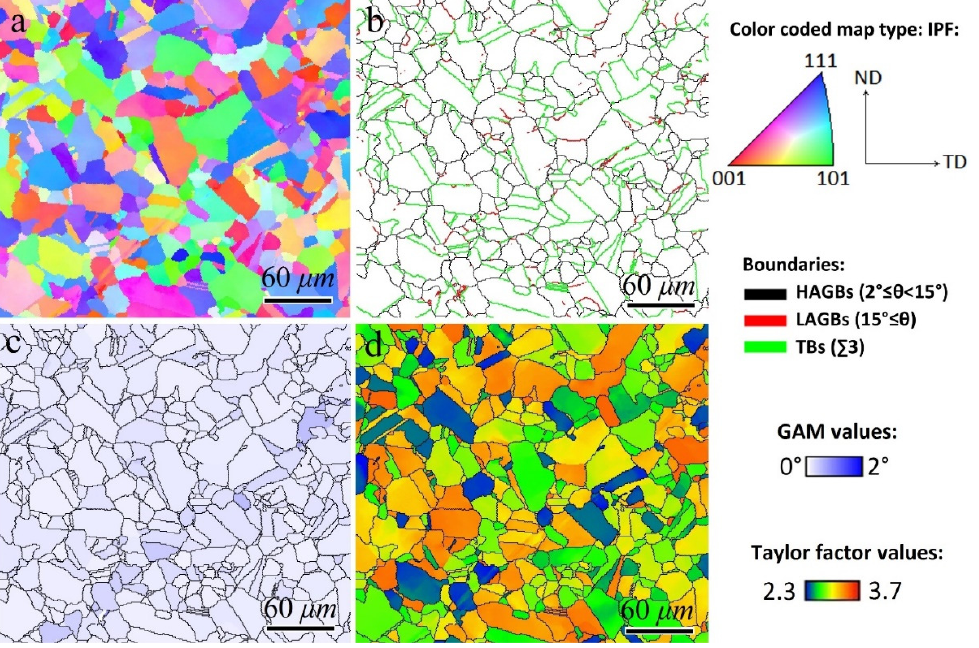
Figure 6. ( a ) IPF, ( b ) grain boundaries, ( c ) GAM, and ( d ) Taylor factor maps of the HH sample.